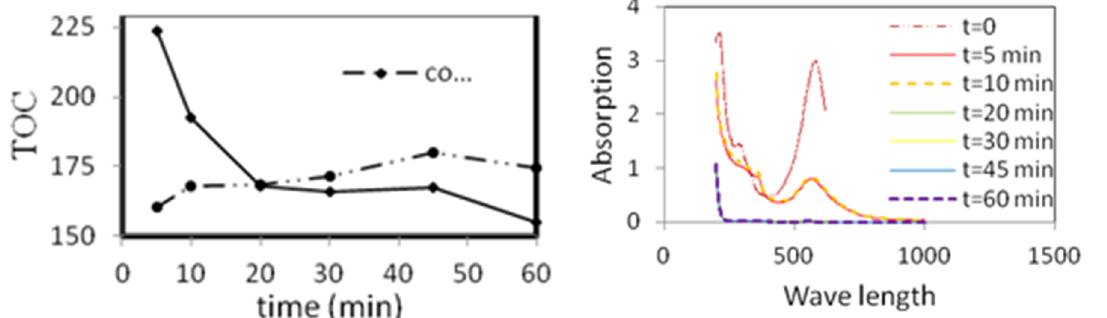
Figure 3. Sample of TOC and absorption removal during SC for the main and the control samples.